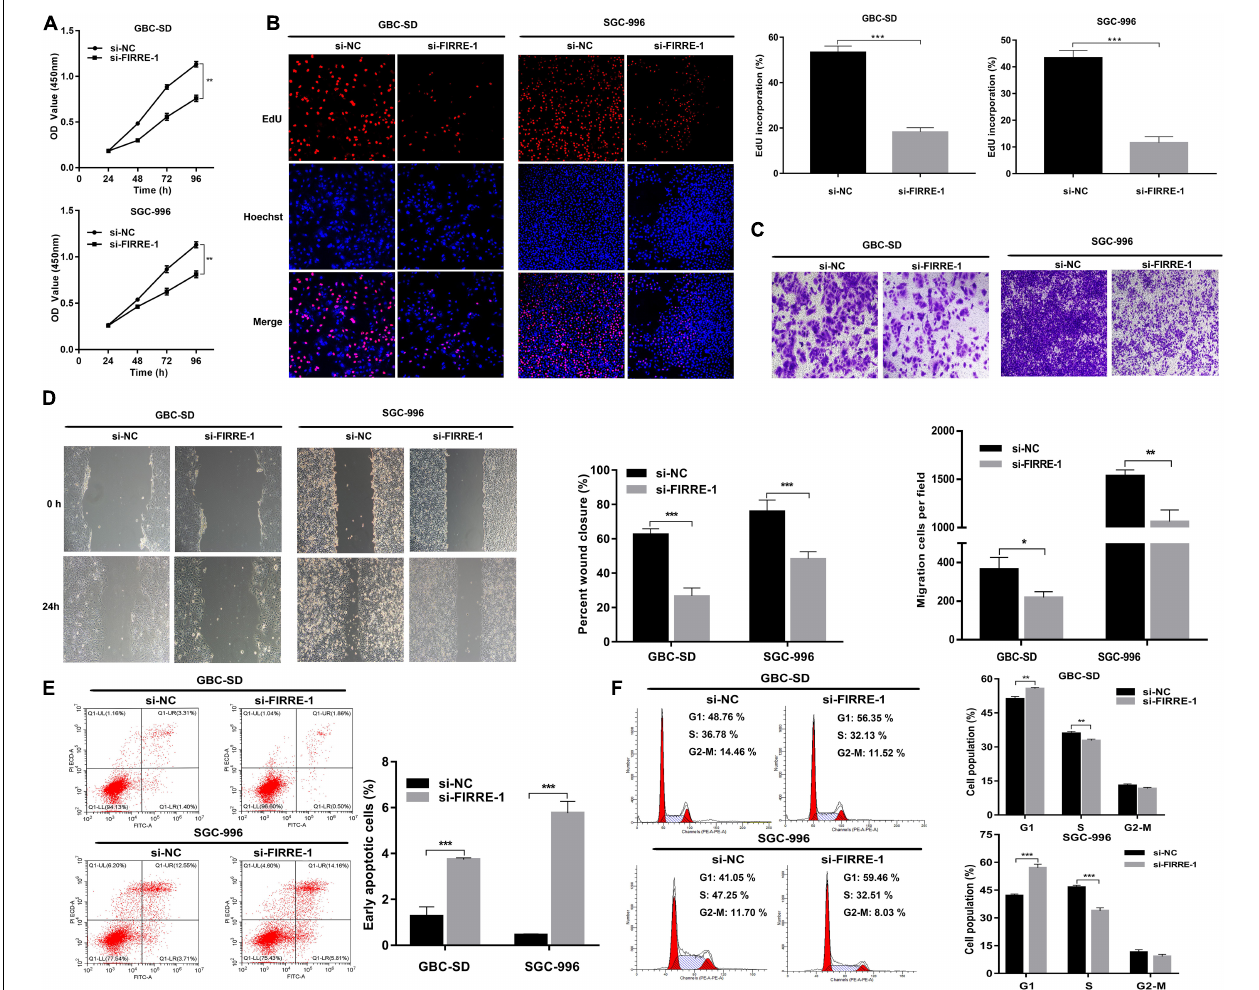
FIGURE 2 | Effect of FIRRE on GBC cells proliferation, migration, cell cycle, and apoptosis in vitro . (A) The proliferation ability of GBC-SD cells and SGC-996 cells transfected with si-FIRRE-1 were determined by CCK-8 assays. (B) EdU assays were conducted in GBC cells after transfection with si-FIRRE-1 (magnification, × 100). Scale bar, 100 µ m. (C) Cell migration was assessed in GBC cells in which FIRRE was inhibited. Scale bar = 100 µ m. (D) The migration ability of transfected GBC-SD and SGC-996 cells by cell wound healing assays. (E) Apoptosis rate was analyzed by flow cytometry after downregulation of FIRRE. (F) Flow cytometric analyses were performed to determine the cell cycle progression in si-FIRRE-1-transfected GBC-SD cells and SGC-996 cells. * p < 0.05, ** p < 0.01, *** p < 0.001.